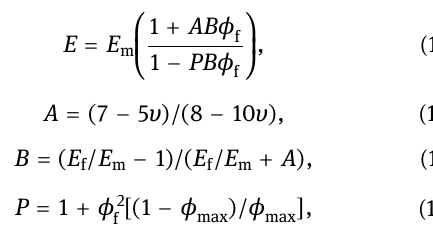
Table 1: The characteristics of the studied SMPNs No.